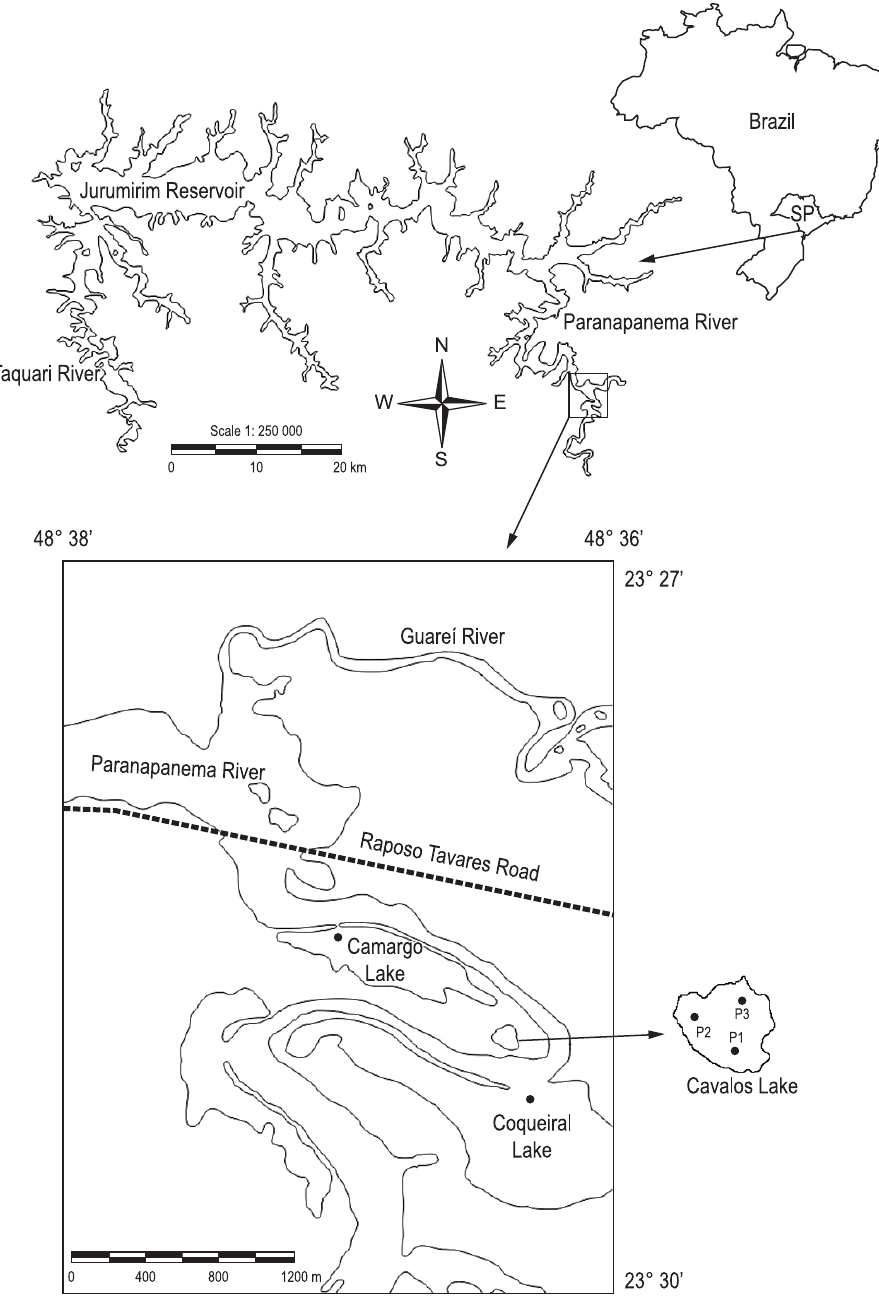
Figure 1. Study area - the mouth zone of the Paranapanema River into Jurumirim Reservoir (São Paulo, Brazil) and Cavalos Lake (Odonata larvae and surface water were sampled at sites P1, P2, and